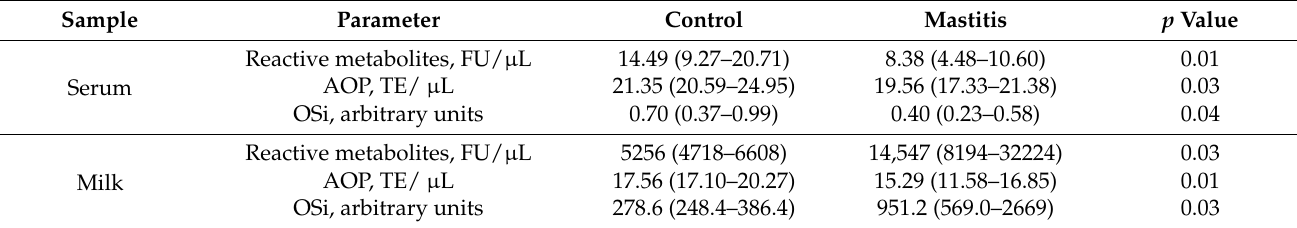
Table 5. Serum and milk reactive metabolites, antioxidant potential (AOP), and oxidant status index (OSi) in dairy cows with systemic mastitis and matched healthy controls (median and range, n =